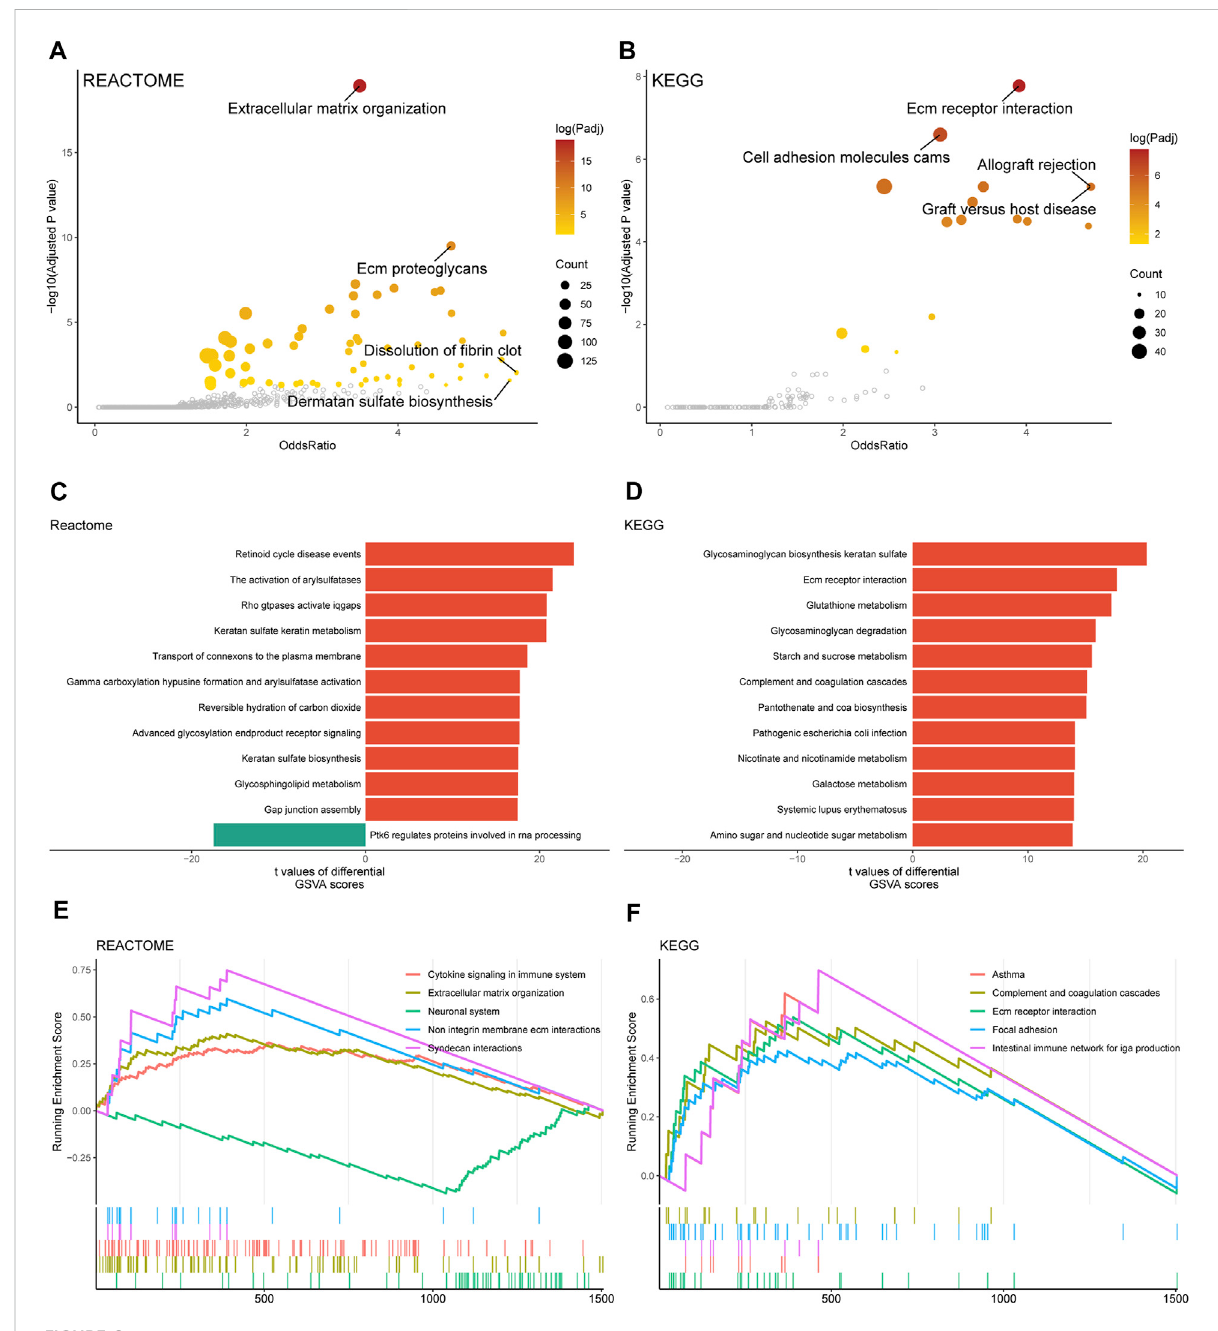
FIGURE 6 Functional enrichment analyses between two SGMRS risk groups. (A) Pathways with high con fi dence and odds ratio in REACTOME gene sets. (B) Pathways with high con fi dence and odds ratio in KEGG gene sets. (C) Top 12 pathways in REACTOME gene set with the highest GSVA scores. (D) Top 12 pathways in KEGG gene set with the highest GSVA scores. (E) Top fi ve pathways in REACTOME gene set with the highest normalized enrichment scores. (F) Top fi ve pathways in KEGG gene set with the highest normalized enrichment